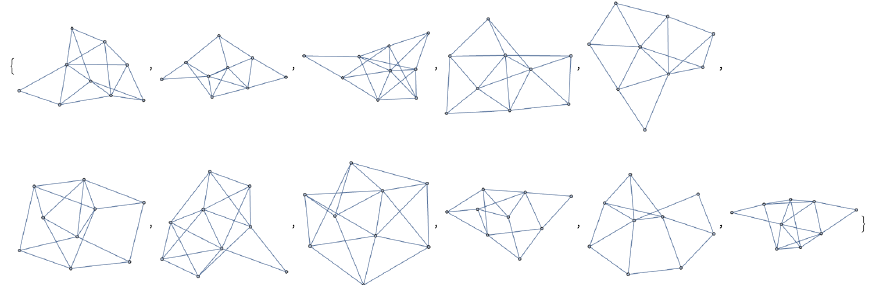
Figure 9. Graph representation of Q [2]